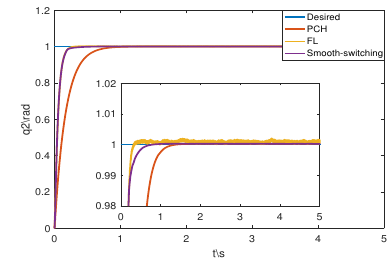
( a ) The unit-step response curve of joint 1. ( b ) The unit-step response curve of joint 2.